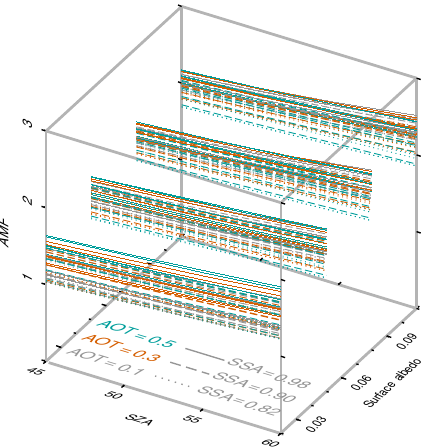
Figure 7. Calculated air-mass factors from the six low surface el- evation scenarios outlined in Fig. 4, plotted as a function of solar zenith angle and surface albedo. A dotted line indicates ω = 0 . 82, a dashed line ω = 0 . 90, and a solid line ω = 0 . 98. AOT is indi- cated by line colour: grey for AOT = 0.1, orange for AOT = 0.3, and blue-green for AO = 0.5. Variation in the AMF due to varia- tions in aerosol properties and vertical profile shape are bounded by a minimum and maximum AMF surface at each surface